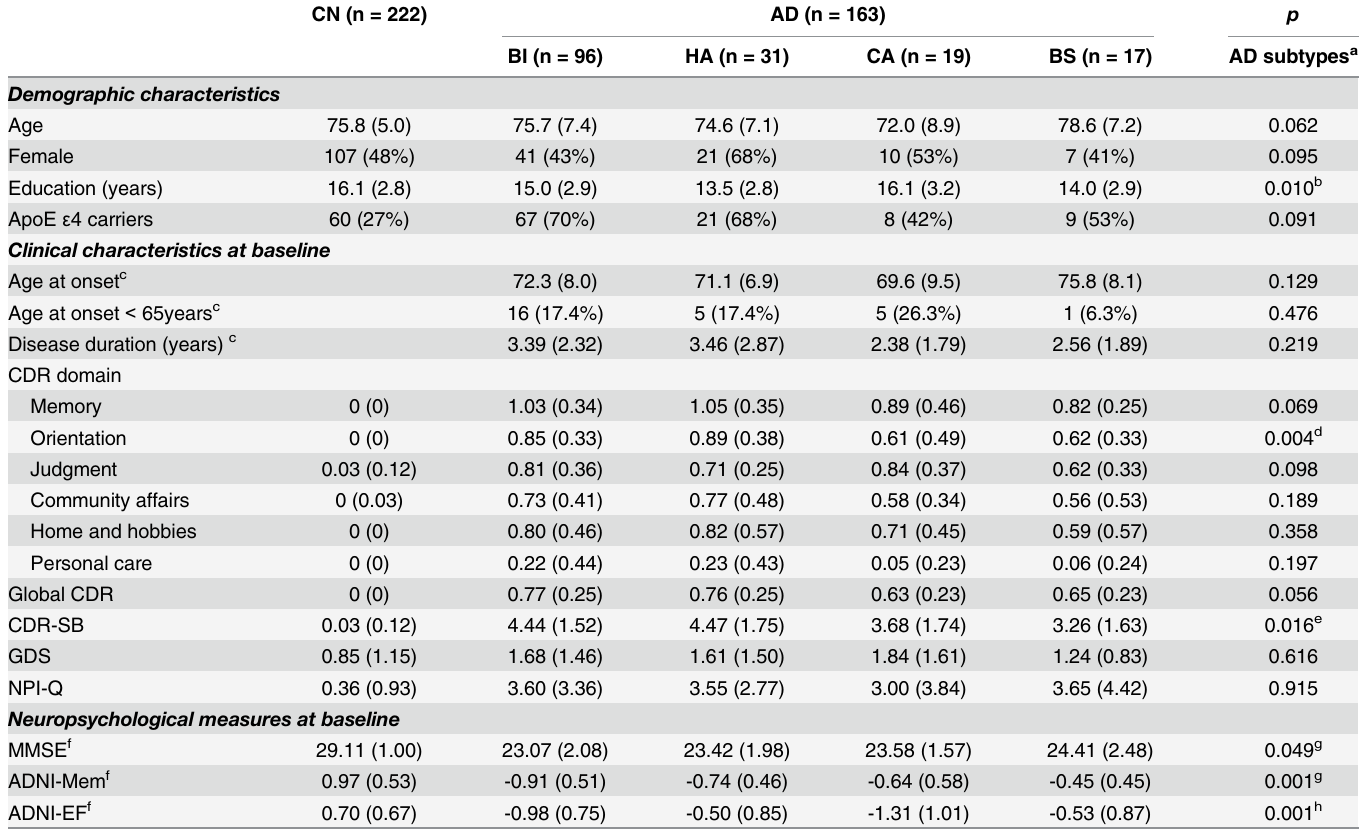
Table 3. Baseline demographic, clinical characteristics and neuropsychological measures of